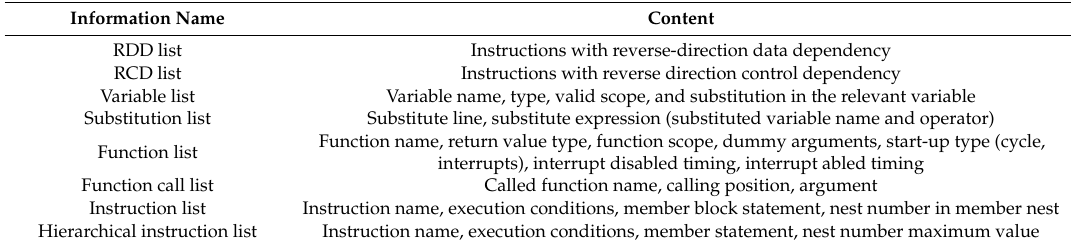
Table 1. List of information extracted from embedded control software (ECSW).